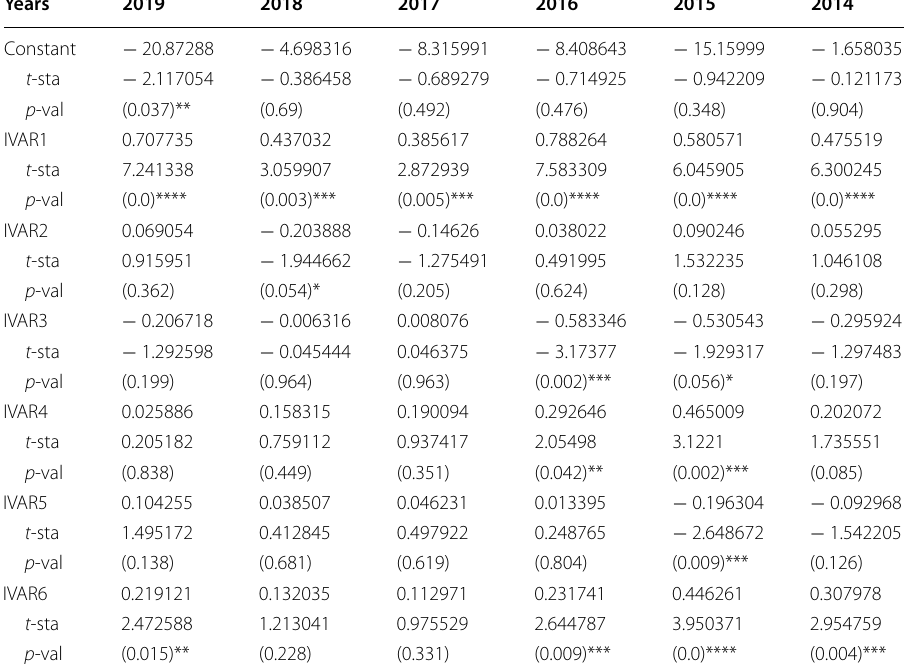
****, ***, ** and * denote statistical significance at the 0.1%, 1%, 5%, and 10% significance level, respectively. The table contains t ‑statistic and their corresponding p ‑values below in brackets